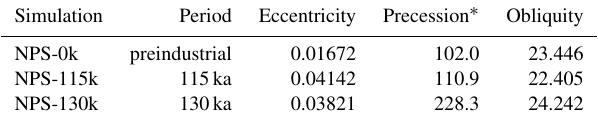
Table 1. Astronomical forcing for all simulations after Berger (1978) in